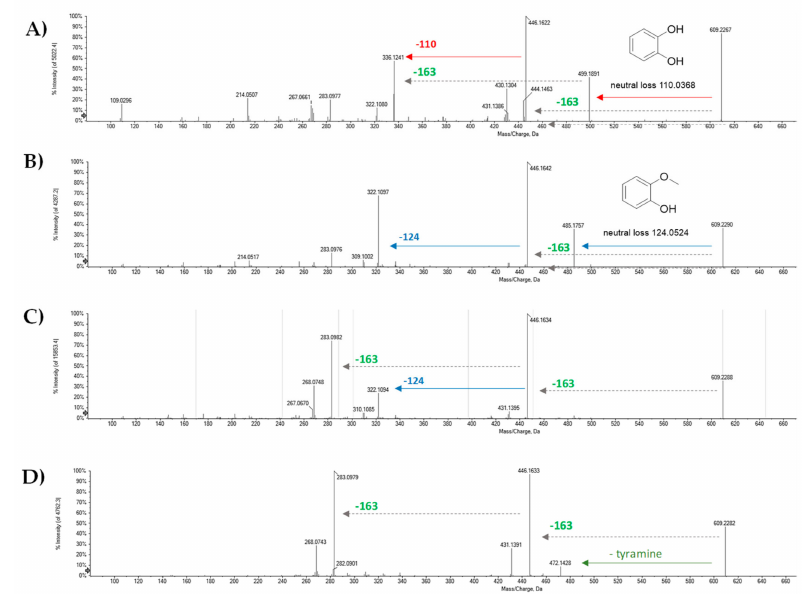
Figure 5. TOF-MS / MS spectra of compounds ( A ) 23 , ( B ) 24 , ( C ) 25 , and ( D ) 35